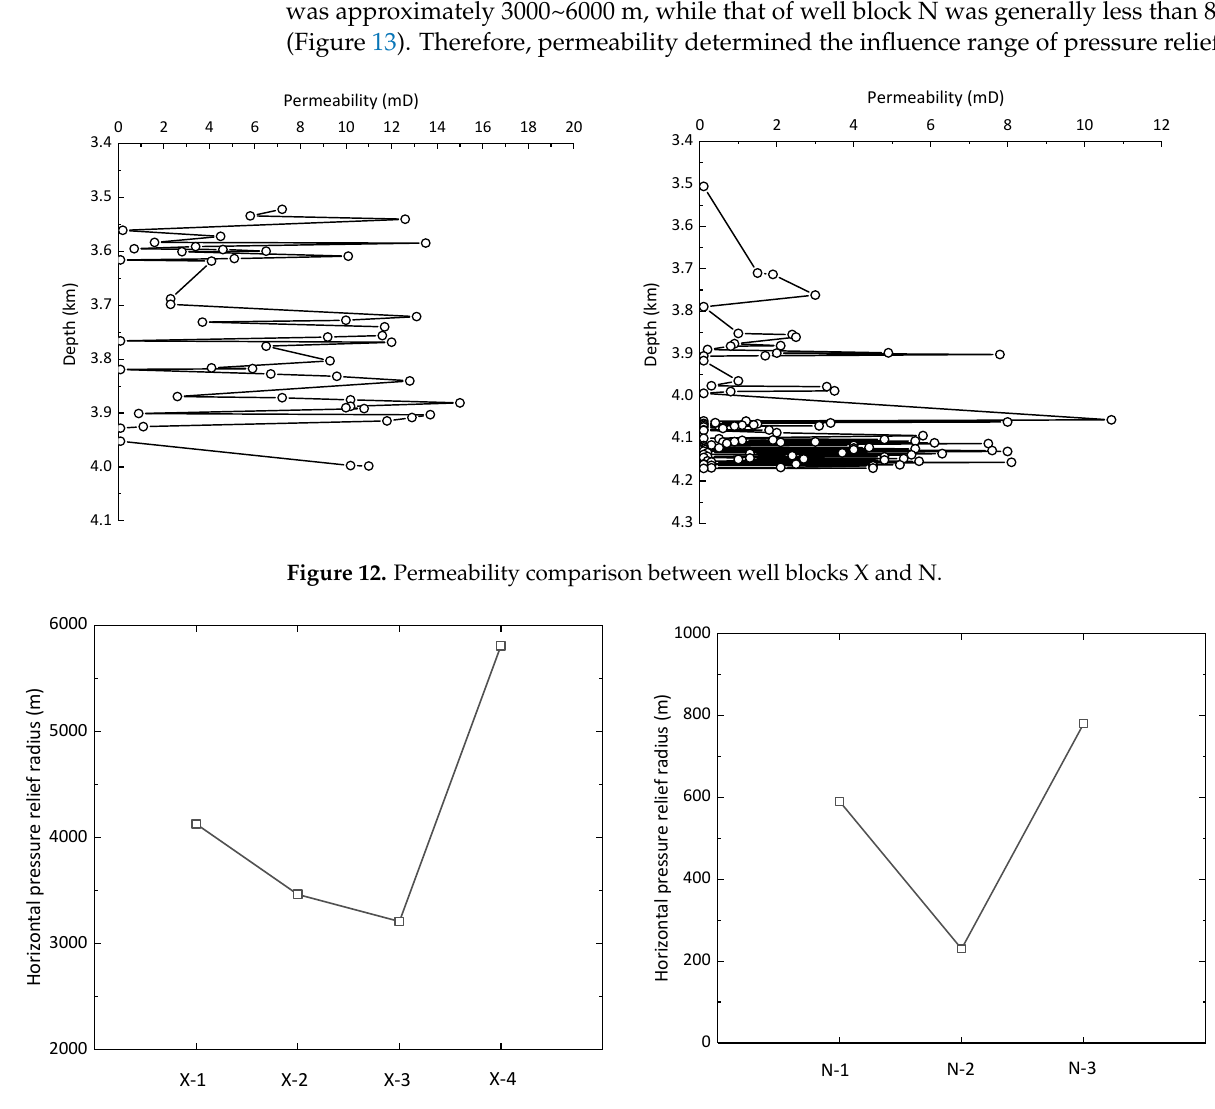
Figure 13. Comparison of lateral pressure relief radius between well blocks X and N.